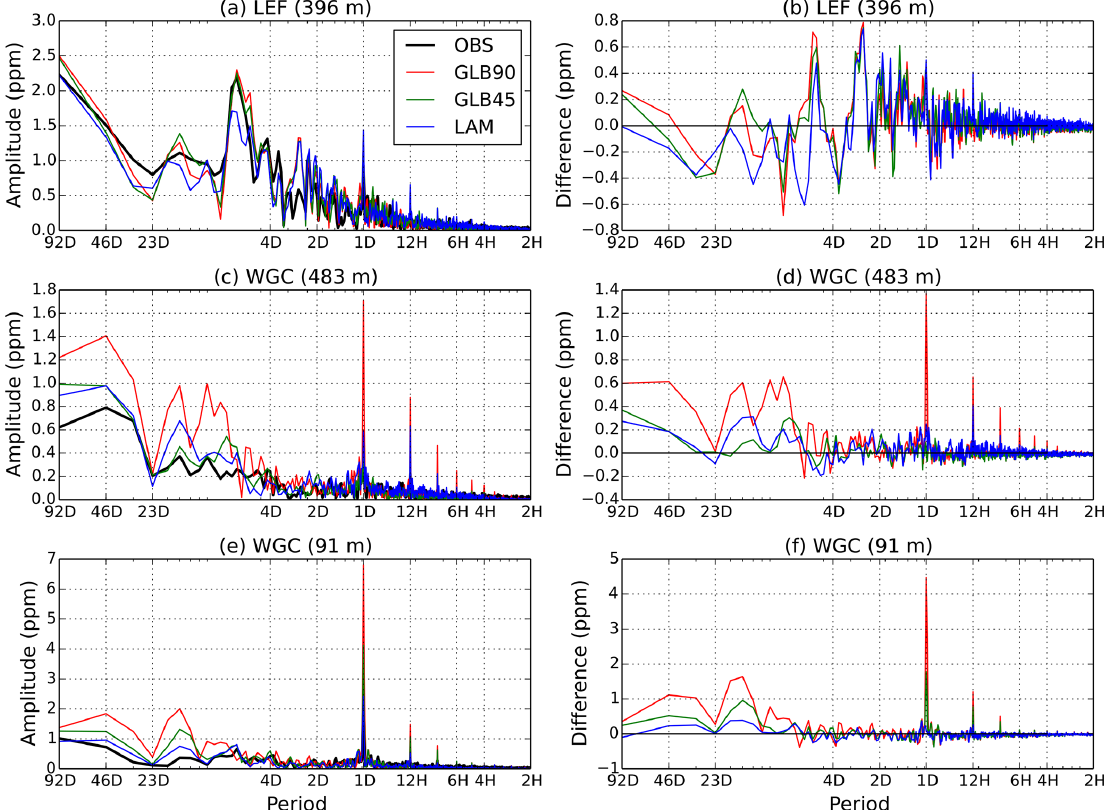
Figure 14. The amplitude of hourly time series of observed CO 2 (black) and modelled CO 2 concentrations from the GLB90 (red), GLB45 (green) and LAM (blue) experiments across temporal scales from 2h to 92d at (a) LEF (intake height of 396m) and (b) their differences, (c) WGC (intake height of 483m) and (d) their differences, and (e) WGC (intake height of 91m) and (f) their